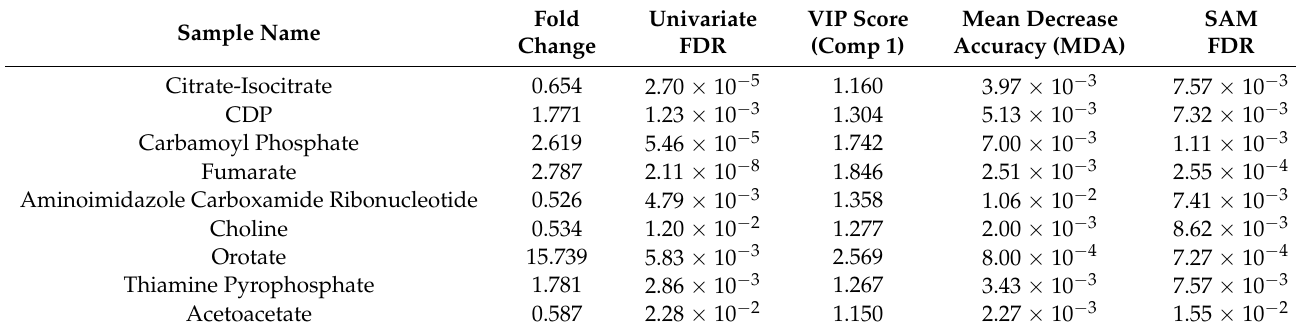
Table 4. Discriminant metabolites identified after treatment with Leflunomide. Test statistics calculated for significantly altered metabolites overlapped across the univariate Student’s t -test, SAM, PLS-DA, and RF